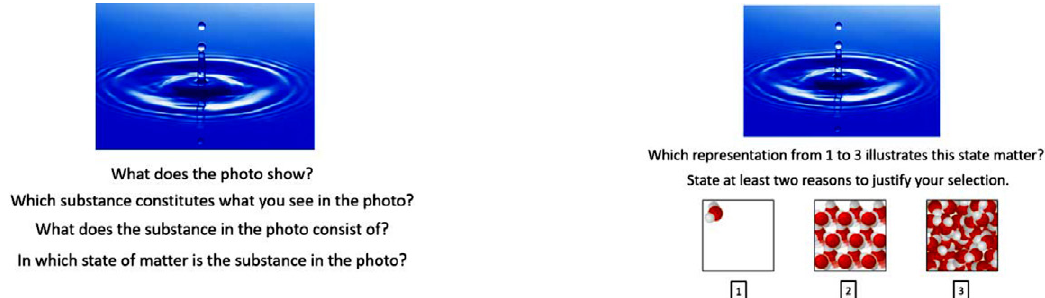
Figure 2. Screen images of the second authentic task, Part 1 (left) and Part 2 (right). (Image of flowing water from